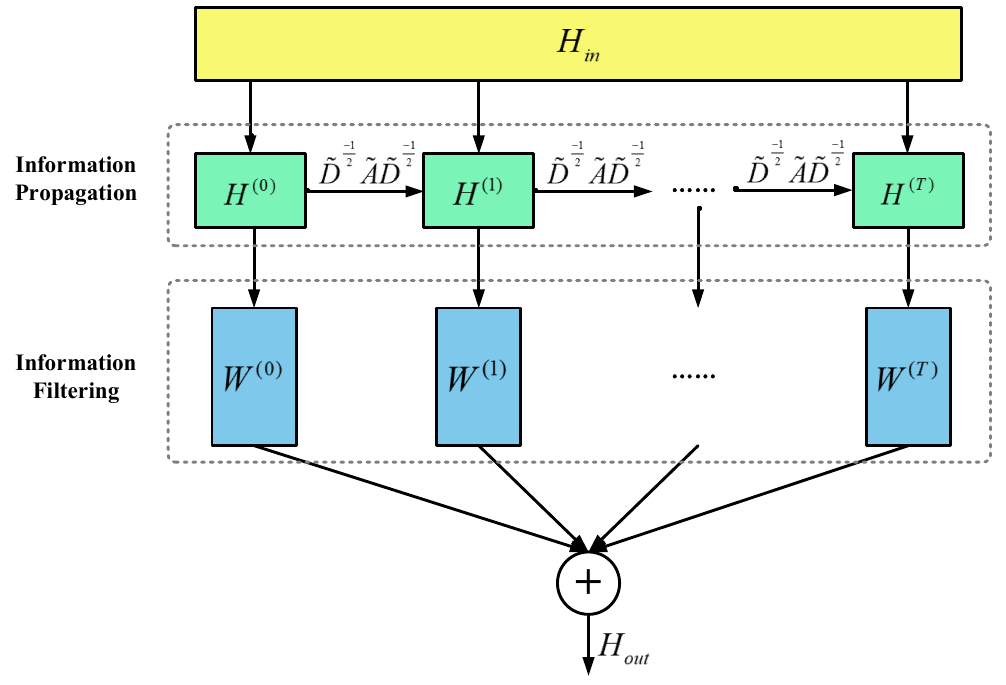
Figure 3. Mix-jump propagation layer.